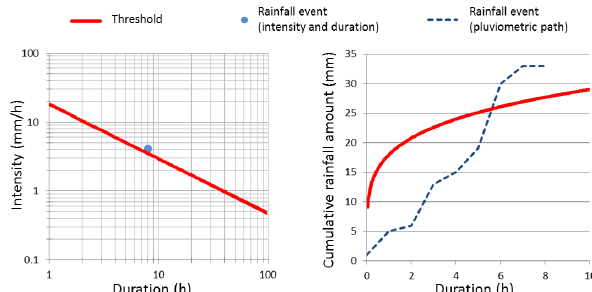
Figure 3. Left panel: a typical log–log I – D plot that allows for comparison of a power-law threshold and a rainfall event expressed in terms of its intensity and duration. Right panel: the same thresh- old and the same rainfall event are expressed in terms of duration and cumulative rainfall amount, allowing for constant monitoring of the evolution of the rainfall path with respect to the warning thresh- old.